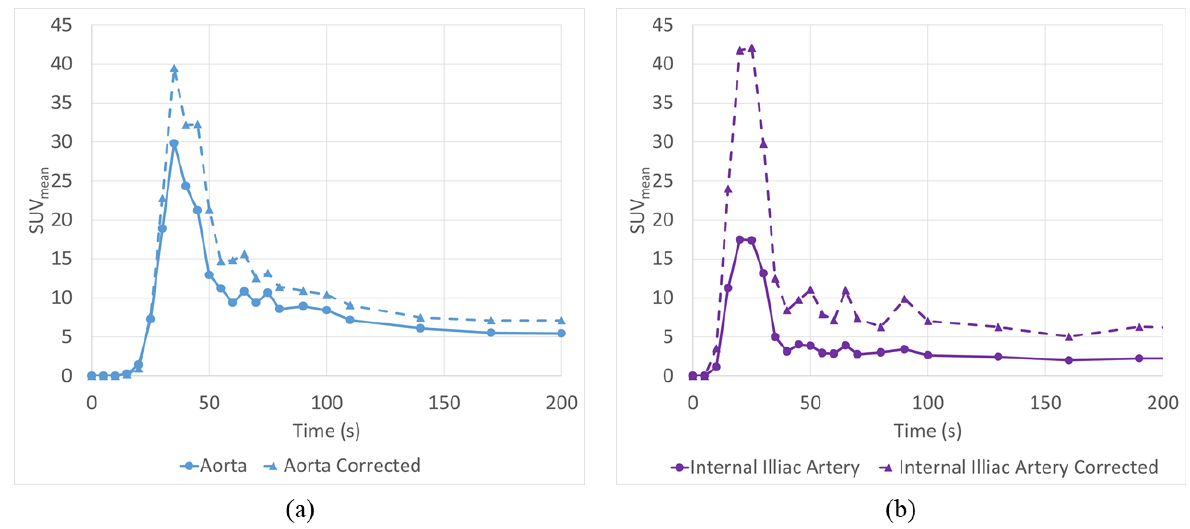
Figure 10. AIF Correction equations were successfully utilized to correct large vessels such as the descending Aorta ( a ) as well as smaller vessels such as the internal iliac artery ( b ) which is affected by both PVE and the neighboring internal iliac vein.